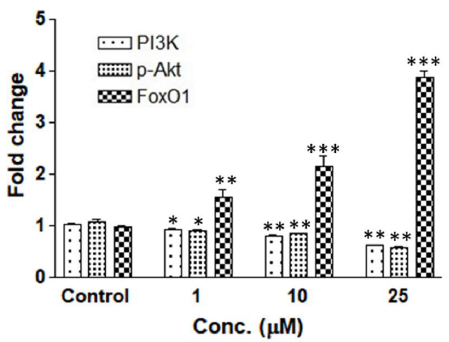
Figure 10. Fold change of PI3K, p-Akt and FoxO1 gene expression of QNP-treated HeLa cells. * p < 0.05 or ** p < 0.01 or *** p < 0.001 as compared to control.